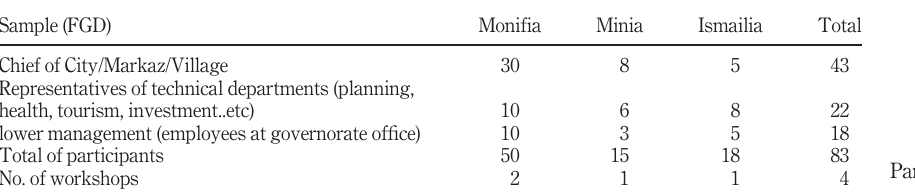
Table II. Participants of